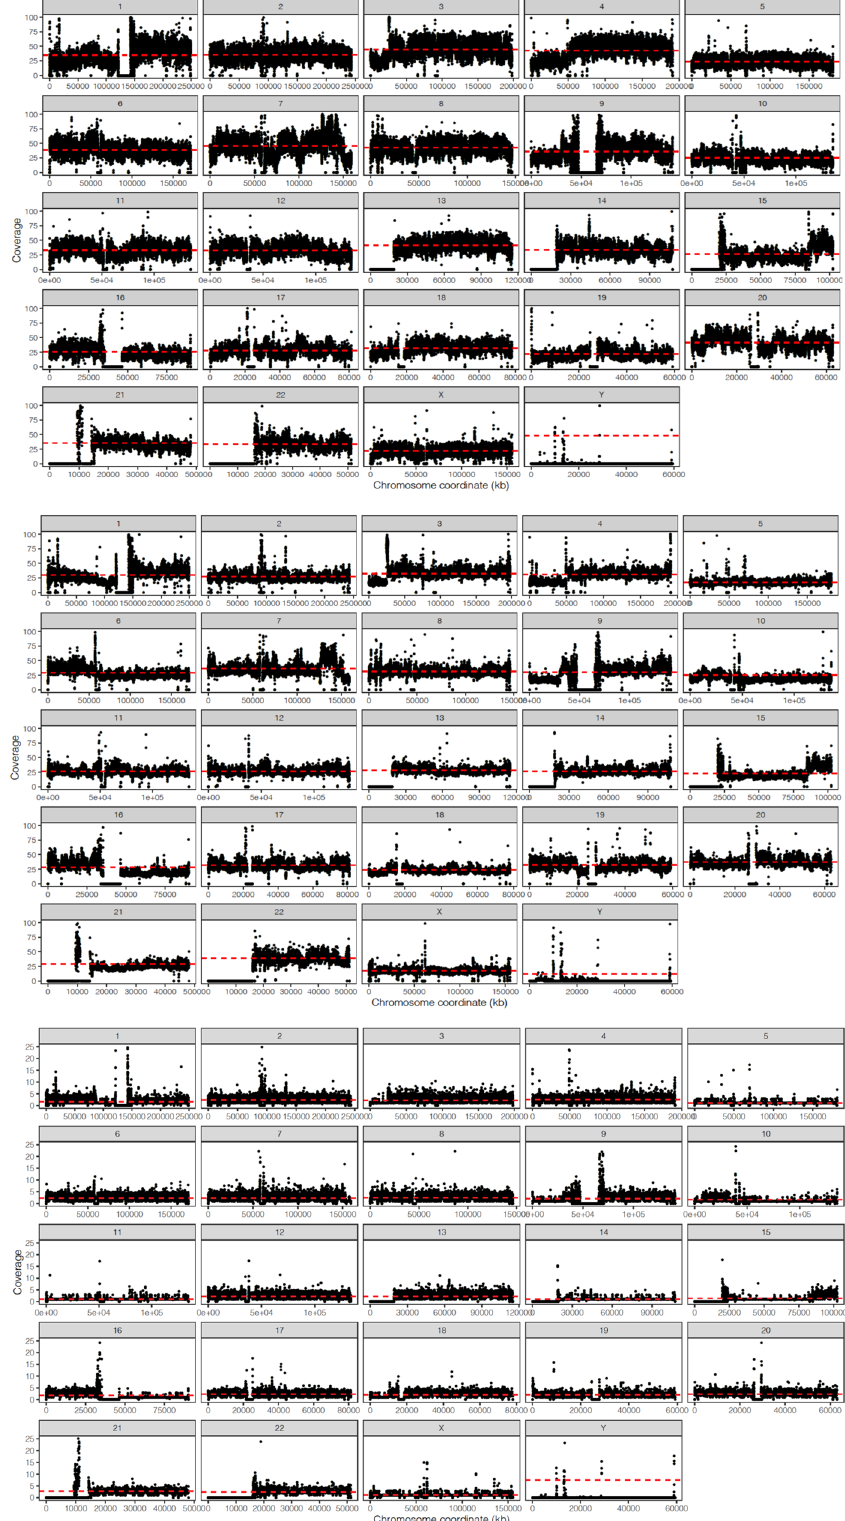
Fig. 6 | Copy number pro fi le correlation on all chromosomes. Coverage dis- tribution from HiFi ( Y axis: 0 – 100) top and HiC data ( Y axis: 0 – 100) middle and pstools phased sequences ( Y axis: 0 – 25) bottom against reference genome, for